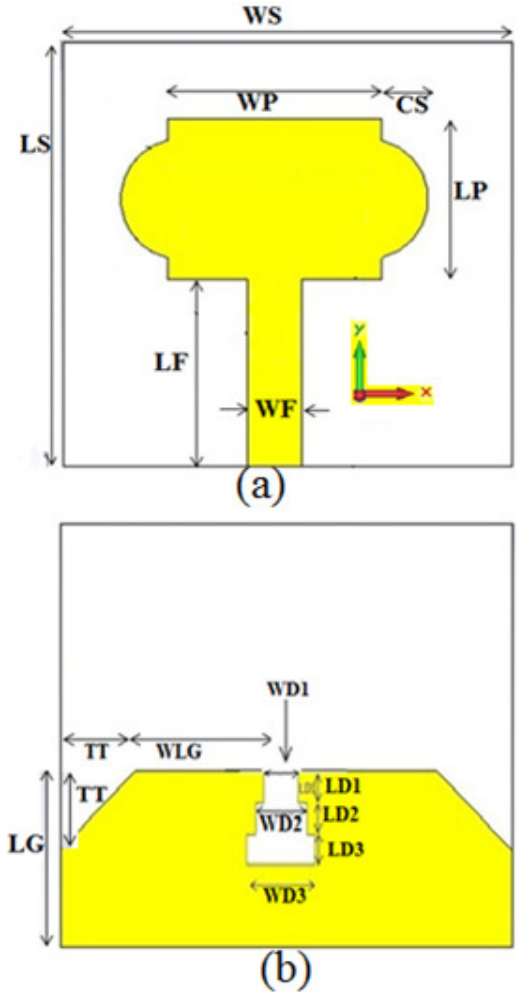
Figure 1: Basic hammer-shaped UWB antenna (a) top view (b) bottom view.